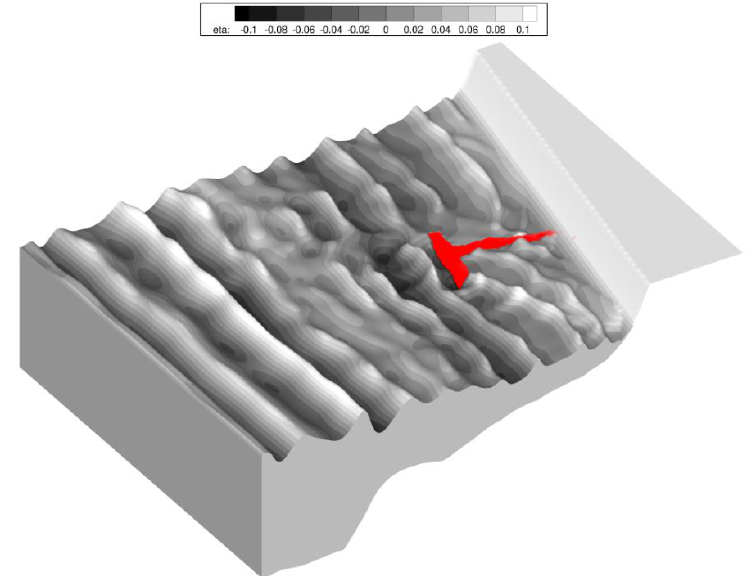
Figure 4. Plan view of the free surface elevation field at time 𝑡 = 100 s .